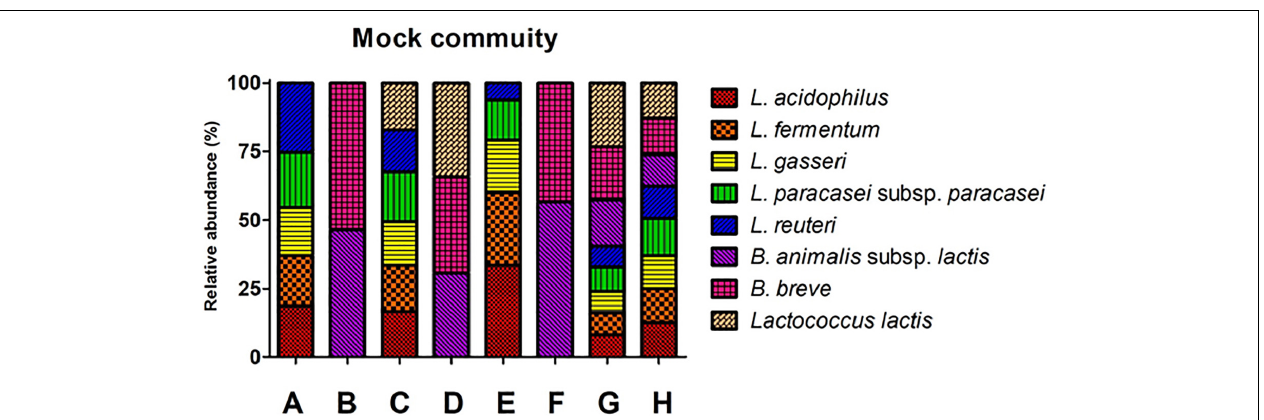
FIGURE 1 | Structures of eight mock communities based on copy number. The percent number in the graph indicates the ratio of each community. A and E: Lactobacillus group, B and F: Bifidobacterium group, C: Lactobacillus and Lactococcus group, B: Bifidobacterium and Lactococcus group, G and H: Lactobacillus, Bifidobacterium and Lactococcus group. The X -axis shows the mock community. The Y -axis indicates relative abundance.